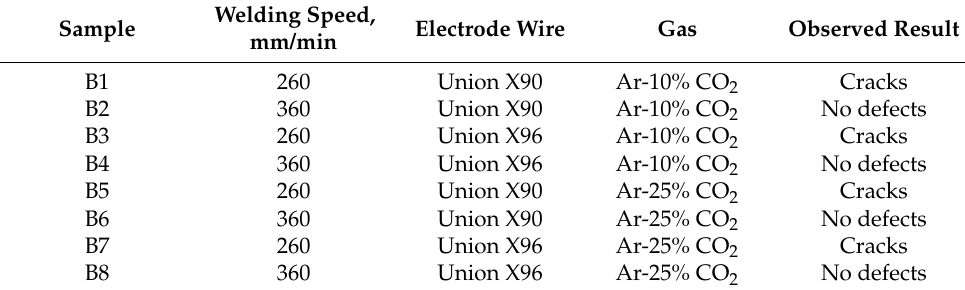
Table 6. NDT test results for connectors made of DOCOL 1200 M steel.